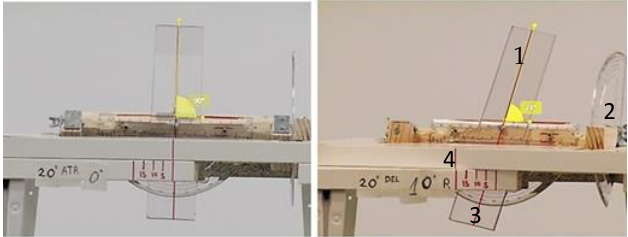
Figure 1. Articulated triplanar goniometric adapted for this study: (1) faithful representation of the hindfoot, (2) sagittal goniometer (3) frontal goniometer, and (4) degree indicator in the sagittal